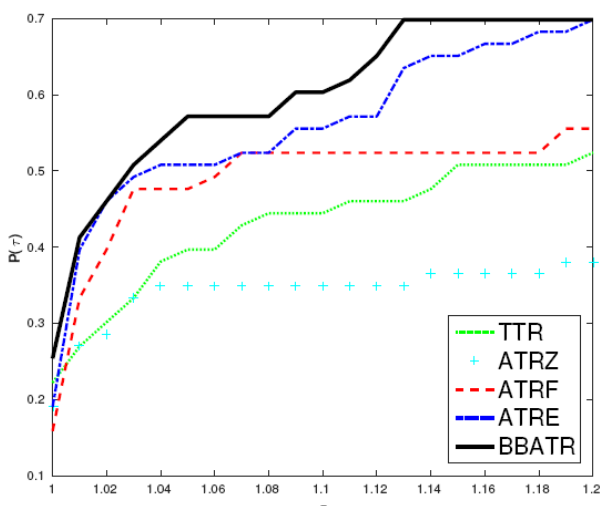
Figure 3. CPU time performance profile for the presented